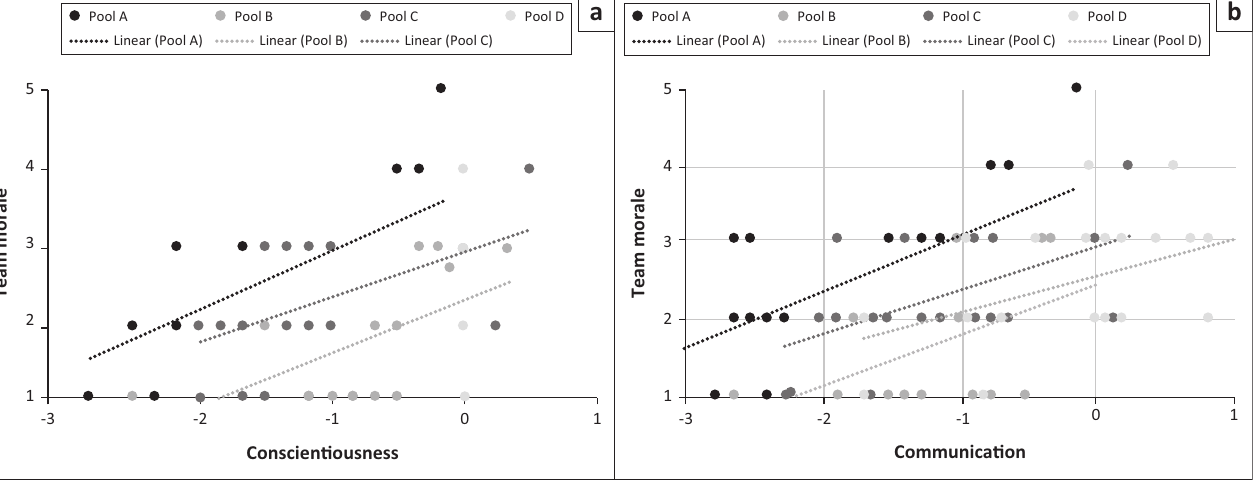
FIGURE 2: Discrepancies (A x _D) versus level of perceived team morale: (a) Conscientiousness; (b) Communication.